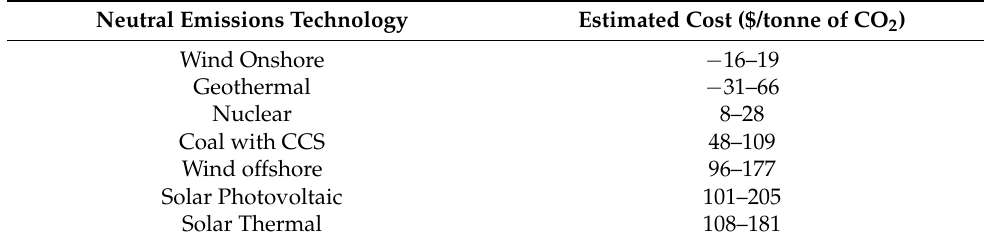
Figure 4. CO 2 avoidance costs of BECCS (in $ per tonne of CO 2 avoided) using a PCC power plant without CCS as the reference case for CAC calculations. Table 3. Neutral emissions technologies and their approximate CO 2 avoidance costs using a PCC power plant without CCS as reference. Data taken from Irlam et al. [29] .